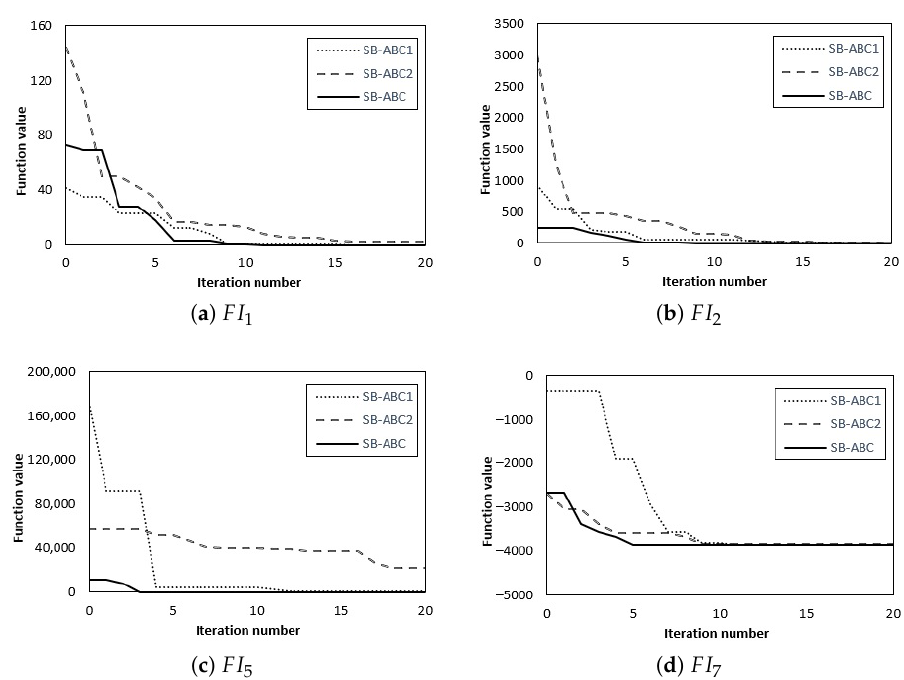
Figure 1. Convergence graphs of SB-ABC1, SB-ABC2 and SB-ABC for the selected integer program- ming problems.